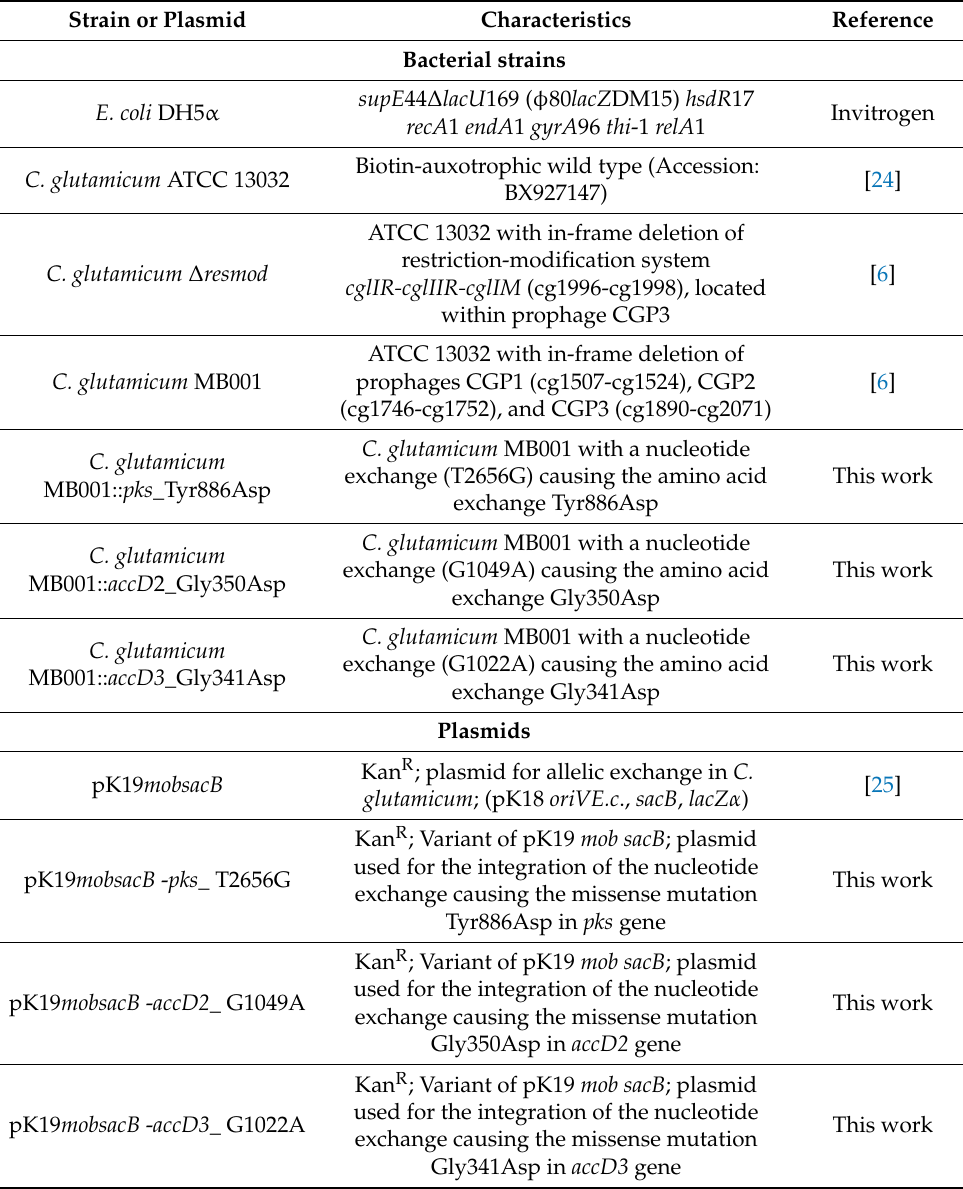
Table 1. Bacterial strains and plasmids used in this